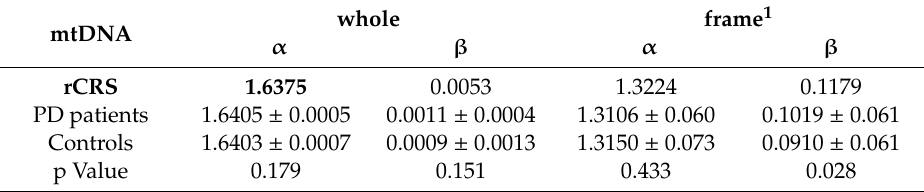
Table 3. Fractal parameters from lacunarity analysis method based on hyperbola model function of mtDNA in Parkinson’s